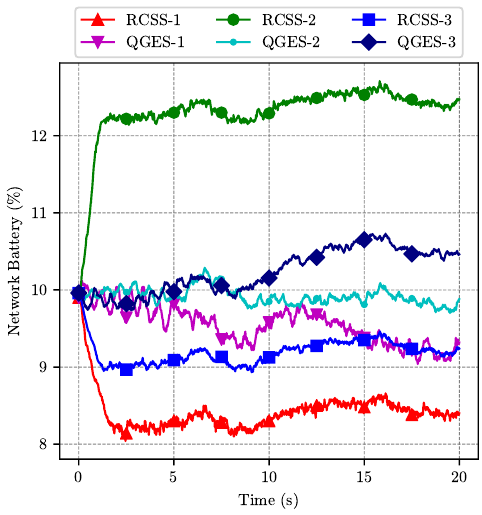
Figure 11. The electric quantity of the nodes with two algorithms.